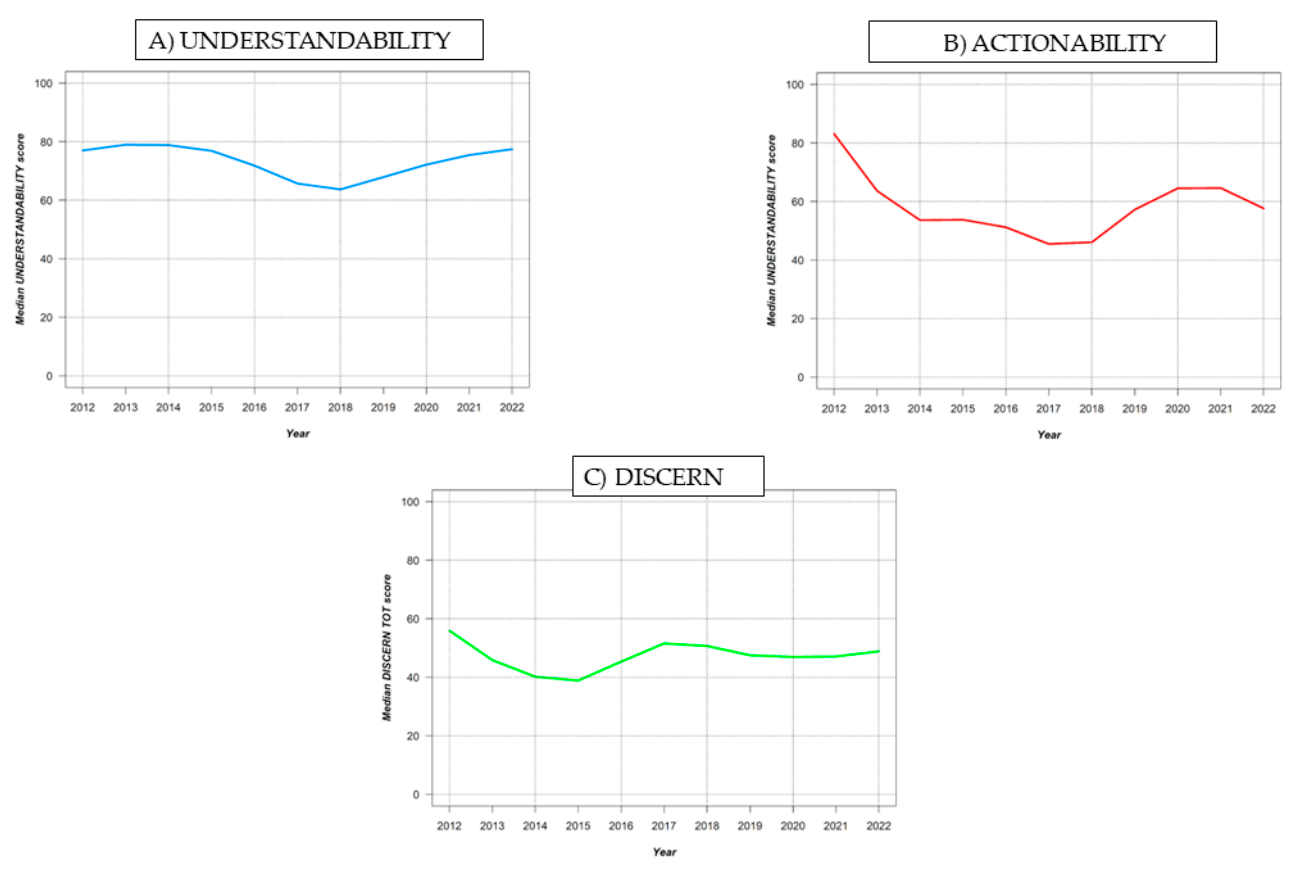
Figure 2 . Understandability, Actionability, and DISCERN total score trends over time. Figure 2. Understandability, Actionability, and DISCERN total score trends over